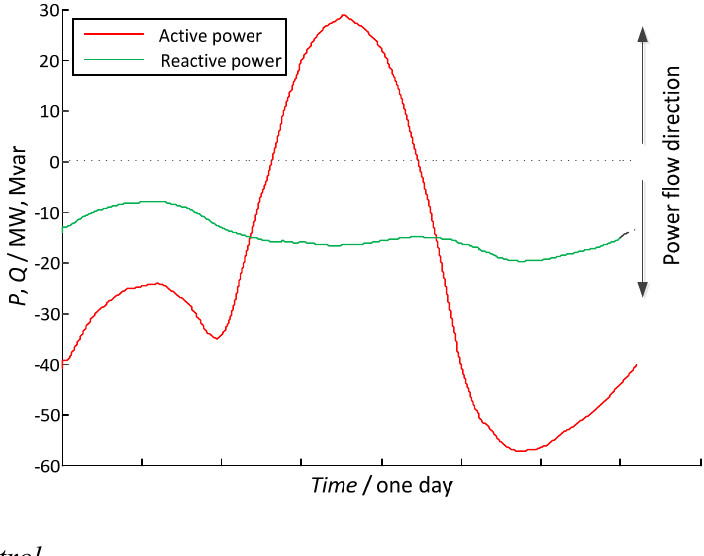
Figure 12. Power flow through the OLTC transformer. It can be seen that during peak h of sunlight, the power flow is